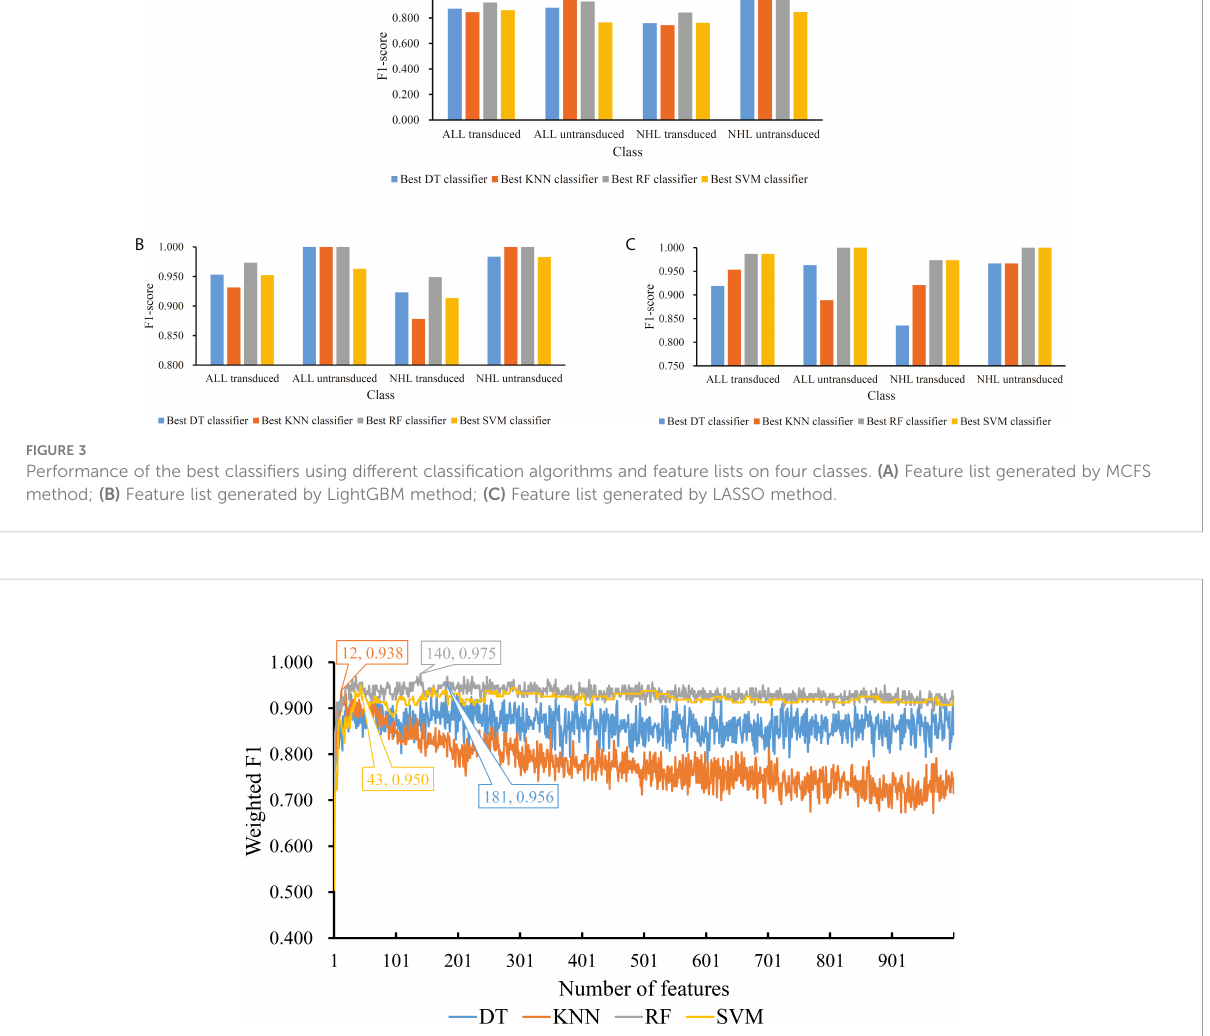
Figure 6. It can be observed that no genes were contained in all three optimal gene sets, three genes ( SERPINB6 , ANK1 , OST4 )